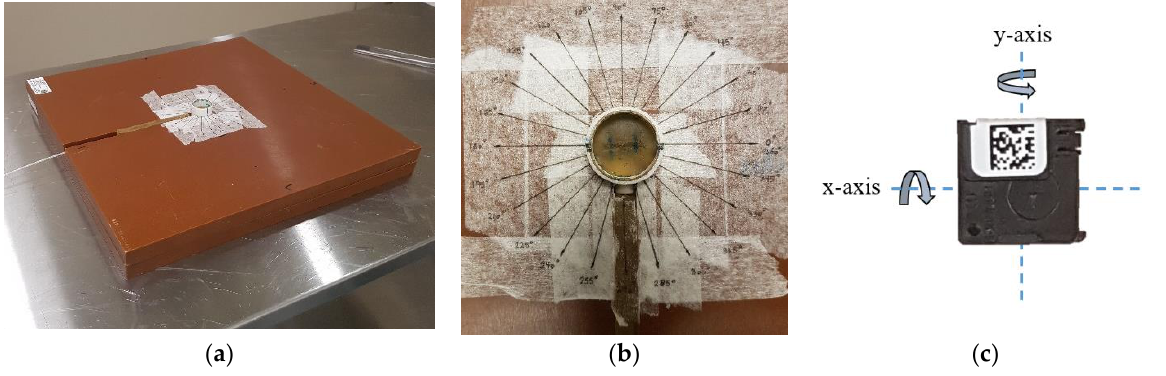
Figure 5. Angular dependence phantom. ( a ) The phantom used to test OSLD angular dependence. Two 2 cm solid water slabs were used, with the top slab having the machined circle in the center and canal for the catheter as shown in the image; ( b ) A close-up of the top of the angular dependence phantom to show OSLD placement within the superflab bolus as well as the marked angles used for the experiment; ( c ) A depiction of how the OSLD was rotated along its x -axis and y -axis.